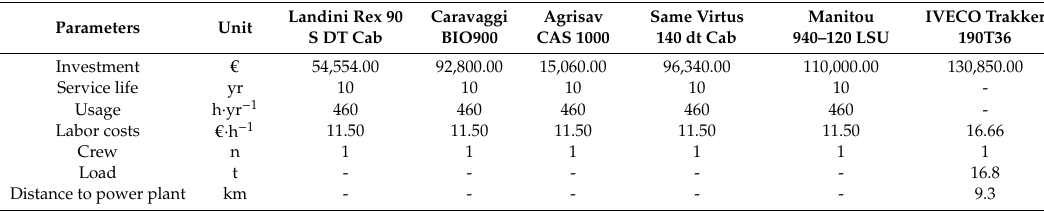
Table 1. Main parameters used for the economic analysis of field operations and